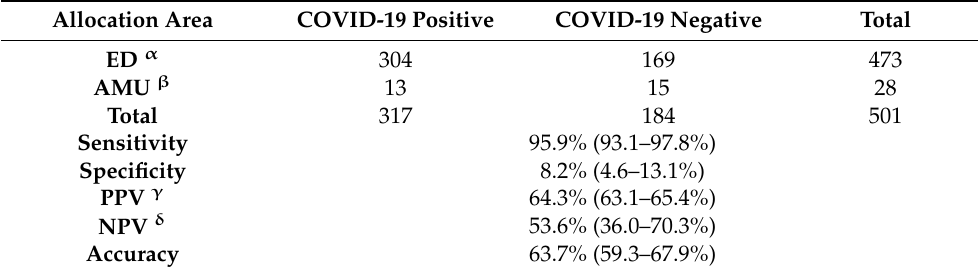
Table 2. Table (2 × 2) of ED and AMU patients with RT-PCR performed.